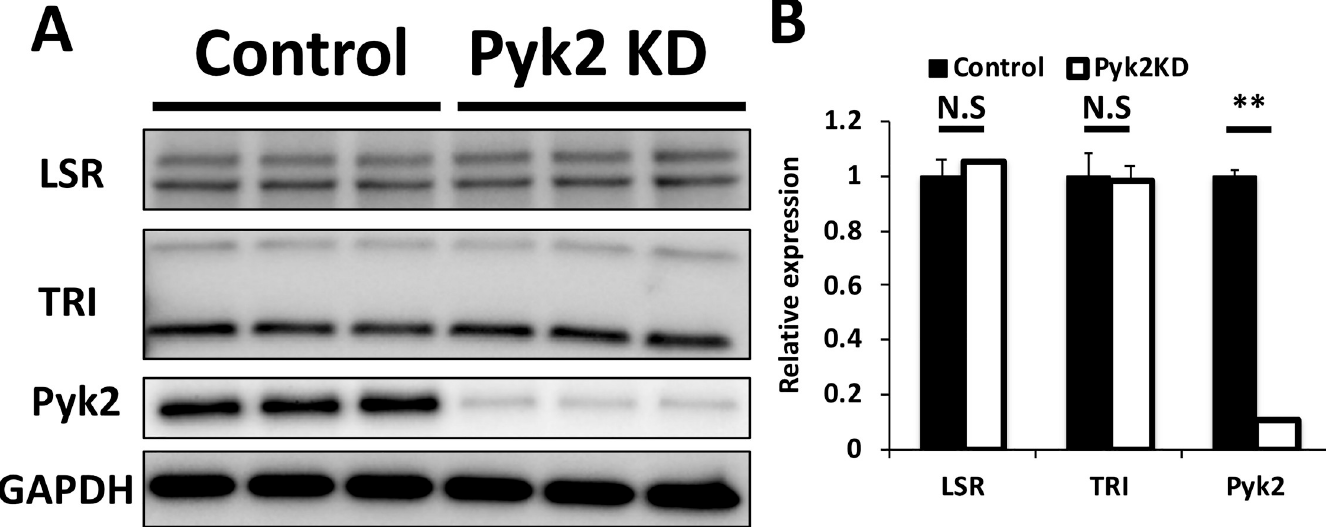
Fig 5. Expression of tTJ proteins in Pyk2-knockdown cells. (A) EpH4-Cl3 cells were transfected with scrambled siRNA (Control) or siRNAs targeted to mRNAs encoding Pyk2 (Pyk2 KD). After 48 h, extracts from control cells or Pyk2-knockdown EpH4-Cl3 cells were lysed and analyzed by immunoblotting using antibodies against LSR (LSR), tricellulin (TRI), Pyk2, and GAPDH. (B) Band intensities of LSR, TRI, and Pyk2 were measured and normalized to GAPDH expression. The expression levels in control cells were set to 1. The means and SEMs are shown in the graph ( n = 3; �� p < 0.01; N.S. p > 0.05).